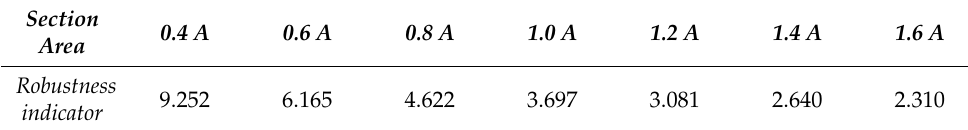
( c ) Structure profile and element size (mm) Figure 3. A c able-bar tensile structure in Inner Mongolia. Figure 3. A cable-bar tensile structure in Inner Mongolia. Table 2. Robustness indicator under various sections (unit: 10 − 4 m/KN).